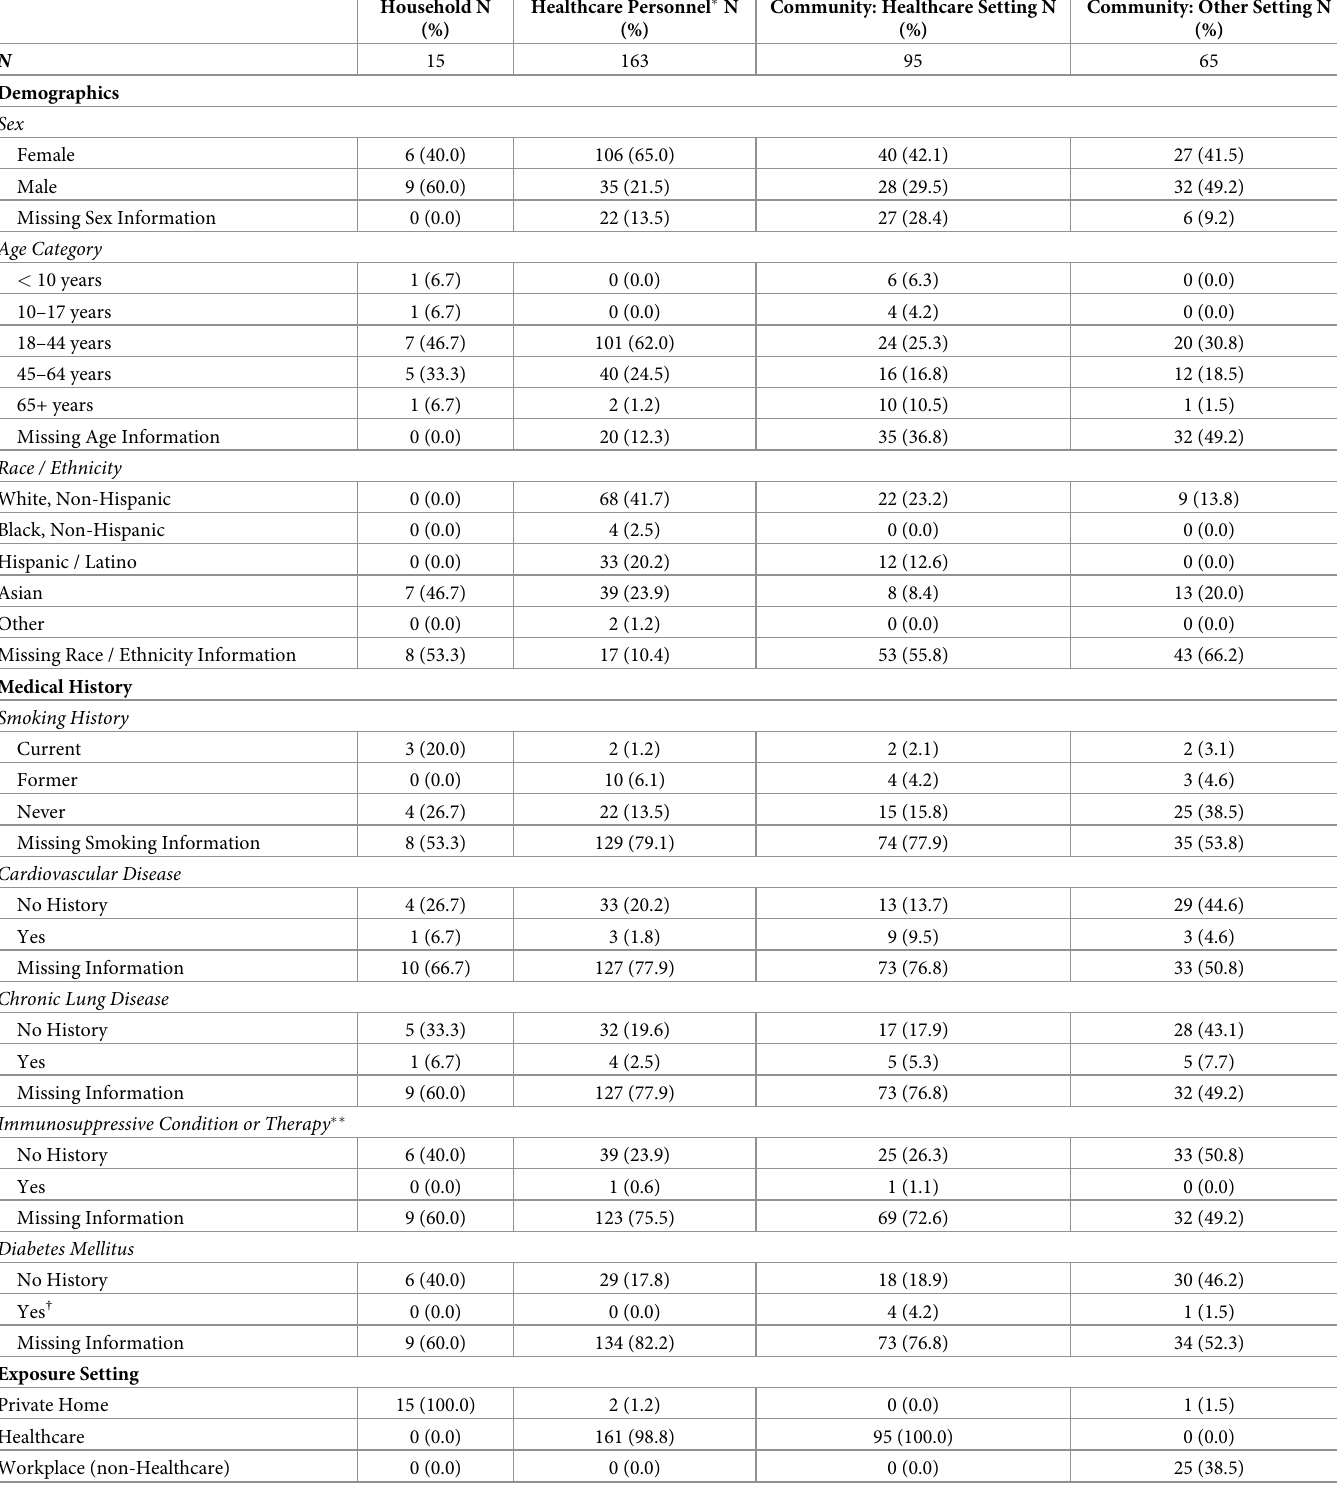
Table 1. Demographic, clinical, exposure, and investigation characteristics among actively monitored close contacts with at least basic data on exposures to 9 con- firmed COVID-19 patients, United States, January–February